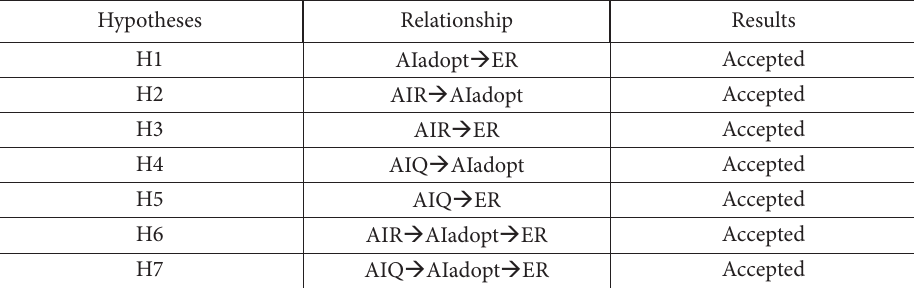
Table 5. Summary of